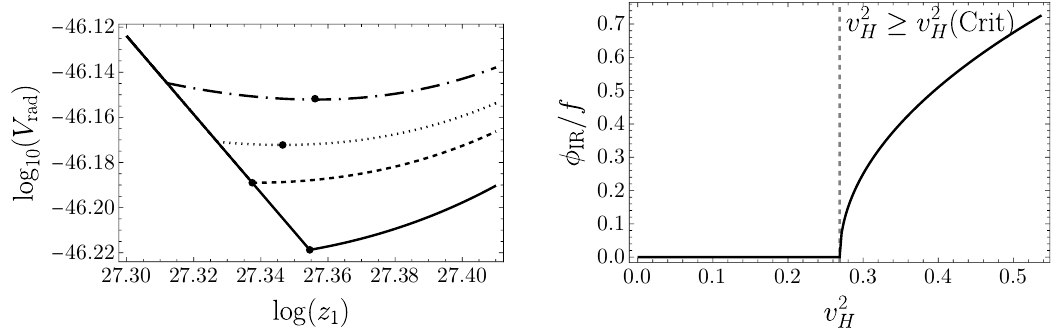
Figure 3. Here we show, on the left, the dependence of the potential on the IR brane parameter v 2 H in the vicinity of the (cid:12)rst critical point. The curves correspond to v 2 = (cid:0) 1 (solid), v 2 = v 2 (crit) H H H (dashed), v 2 = 1 (dotted), and v 2 = 2 (dot-dashed). The dots indicate the minimum of the H H potential. The minimum moves into the region where the Higgs VEV is nonzero after some critical point v 2 (crit). On the right, we show the value of the Higgs (cid:12)eld on the IR brane in units of H the scale f = z (cid:0) 1 , where z min is the location of the minimum of the radion potential. The VEV min (and Higgs mass/inverse of the correlation length), which is proportional to (cid:30) IR , is vanishing below v 2 (crit), and grows quickly after the critical point is H